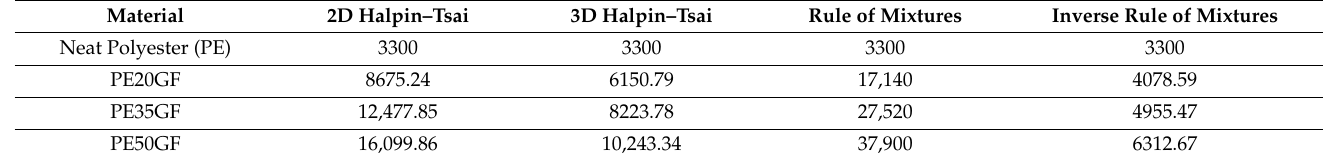
Table 3. Predicted Young’s modulus values in MPa, for polyester and glass fibre-reinforced polyester